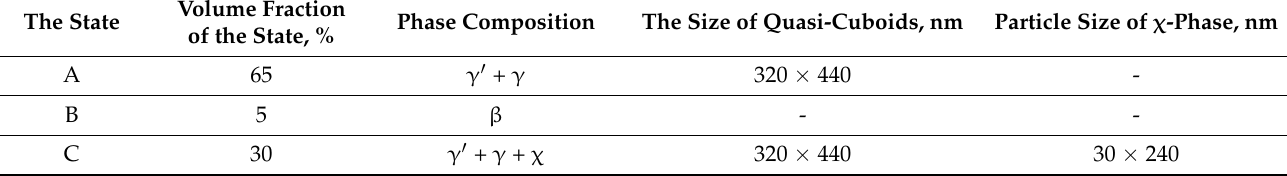
Table 2. Structural phase states of the alloy and their quantitative data after DC.